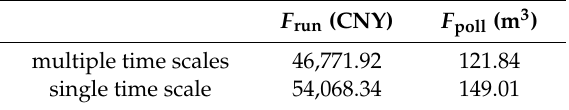
Table 2. Comparison table of results for multi-time scale and single-time scale